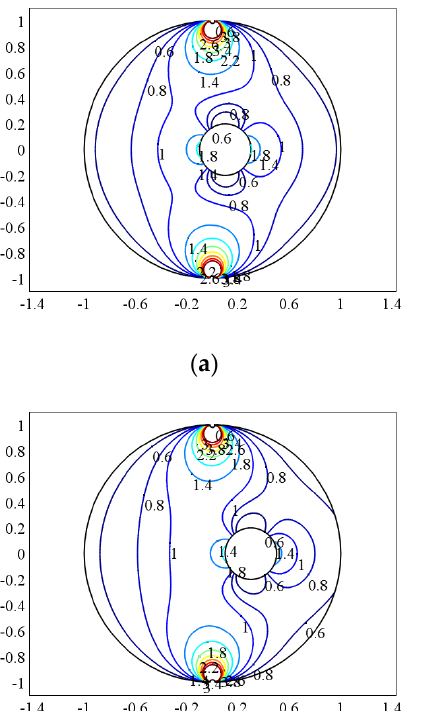
( d ) Figure 5. The w eight function distribution at b = 0. ( a ) e = 0.1, ( b ) e = 0.2, ( c ) e = 0.3, ( d ) e = 0.4. As shown in Figure 5, when the bubble and the two electrodes are located on the same line, the weight function near the upper and lower electrodes all changes. The closer the bubble is to the electrode, the more the weight function near the electrode changes, which indicates that the fluid near the electrode has more and more influence on the output signals of the sensor. In contrast, the